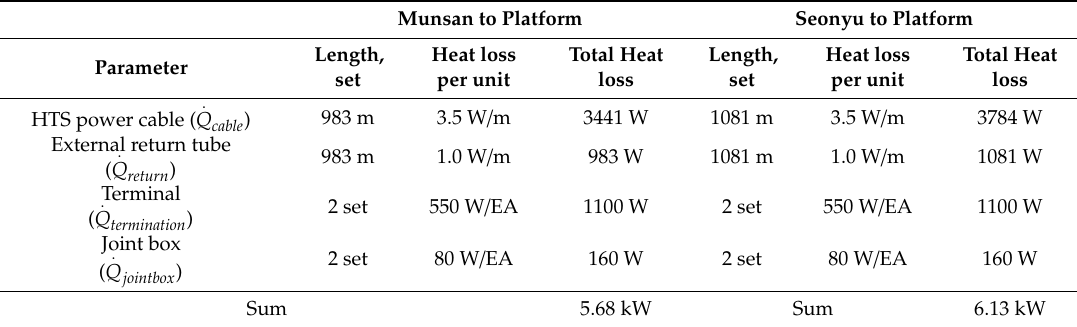
Table 4. Heat loss of the triaxial HTS power cable with external return